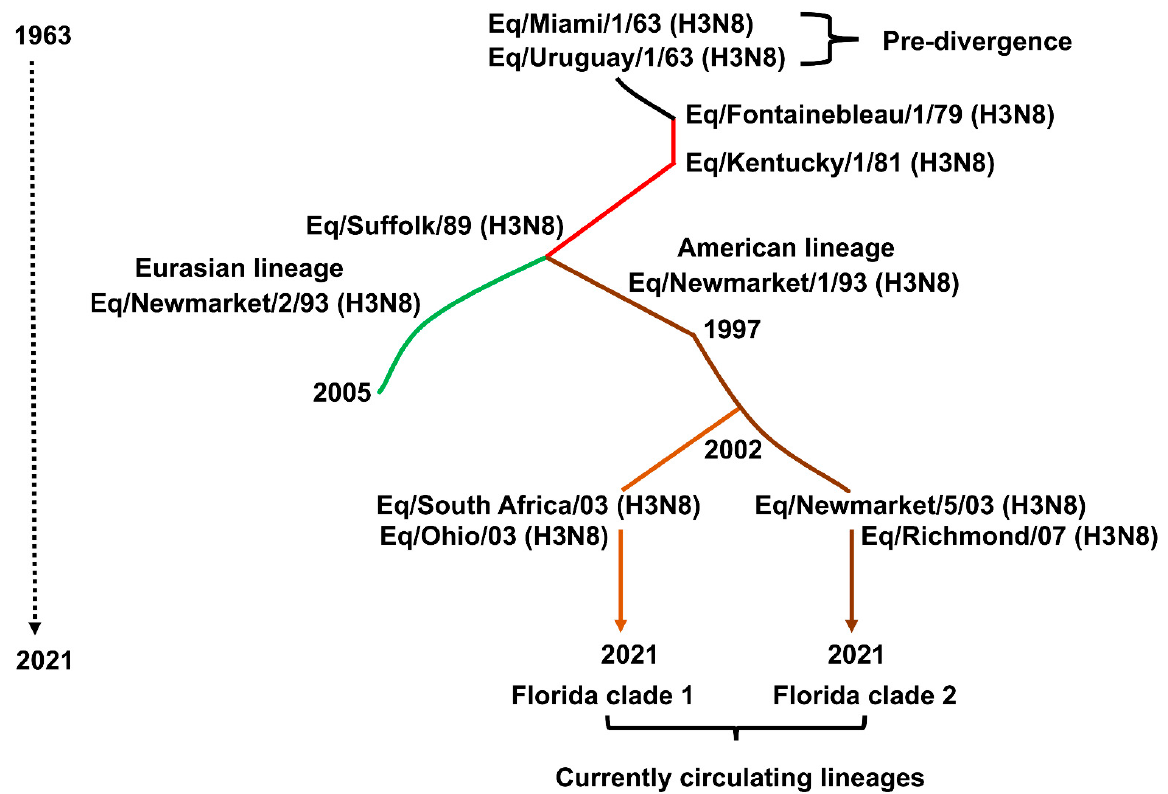
Figure 4. Schematic of evolution of EIV HA, 1963 to 2021. The major lineages as discussed in the text are indicated, as are representative virus strains. Not to scale.